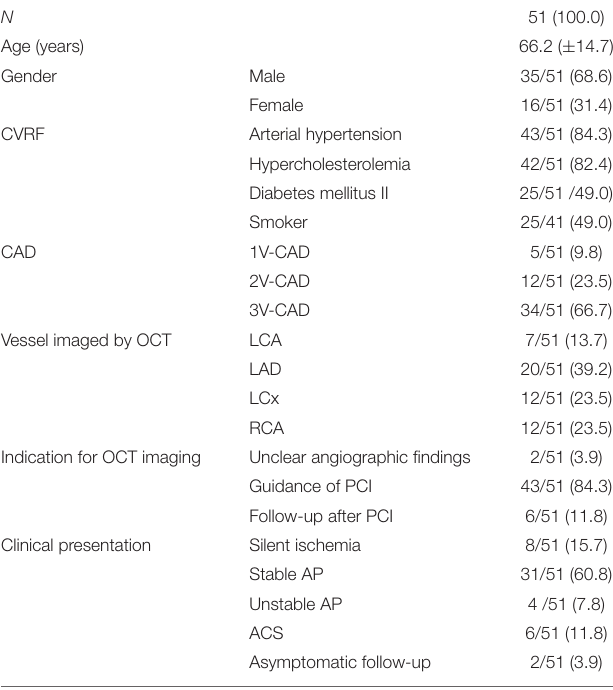
TABLE 3 | Baseline characteristics of clinical data